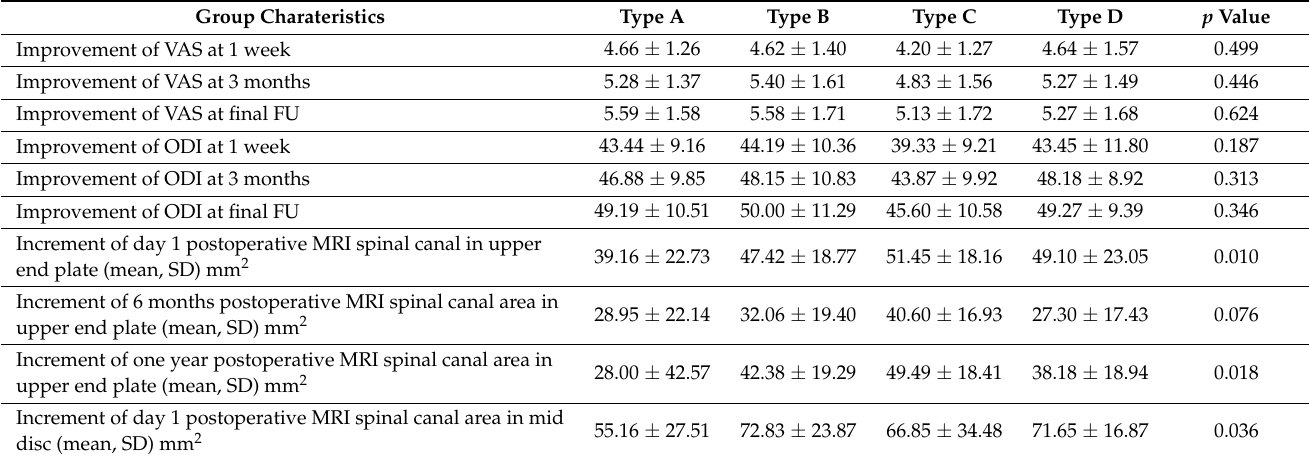
Table 4. Comparison of Clinical and Radiographic Parameters of Patients who underwent LE-ULBD with Four Types of Postoperative MRI canal remodeling. p -Value was derived from ANOVA test, and Tukey’s multiple comparison test was used for the post-hoc